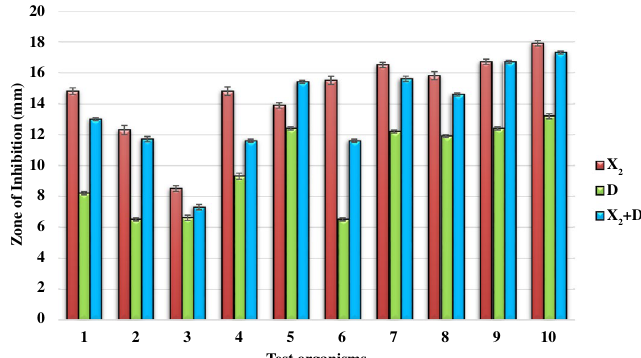
Figure 7. Primary antimicrobial screening of isolated actinomycins X 2 and